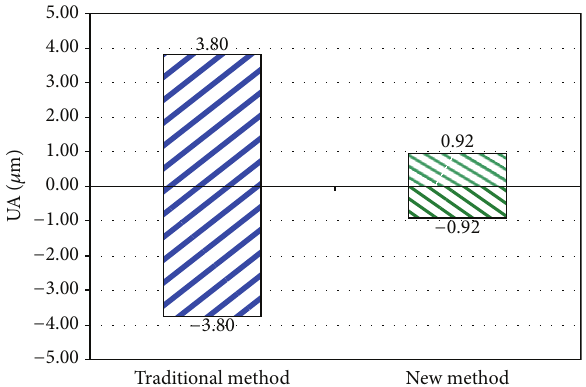
Figure 8: Expanded uncertainty for traditional and proposed obtained